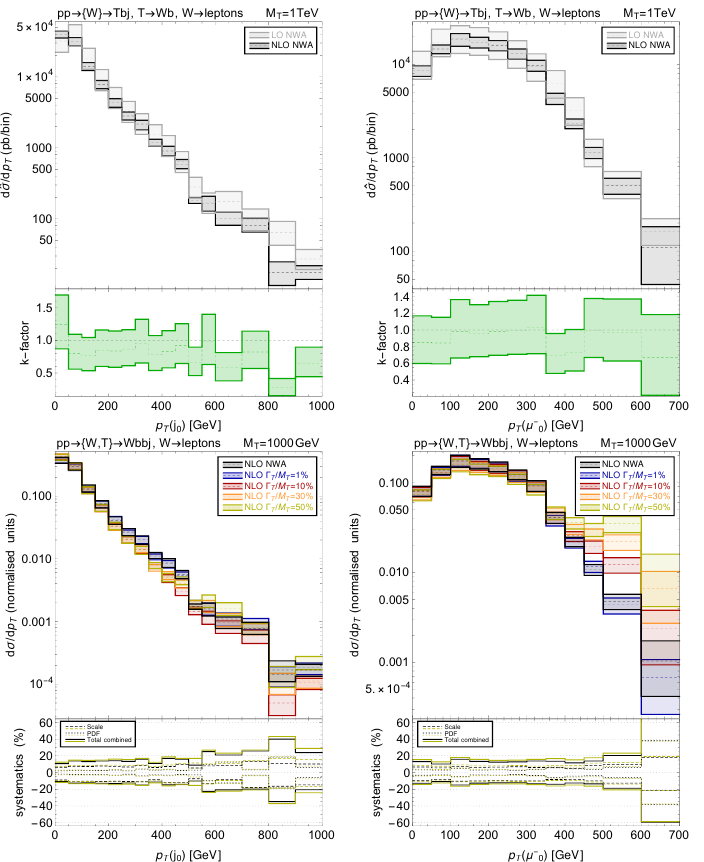
Figure 14 . Distributions of the transverse momentum of the leading jet (left) and of the leading muon (right) for single T production in association with a jet. We fix m consider the pp → { W, T } → Wbbj channel when the W -boson decays leptonically. We refer to figure 13 for the description of the presented